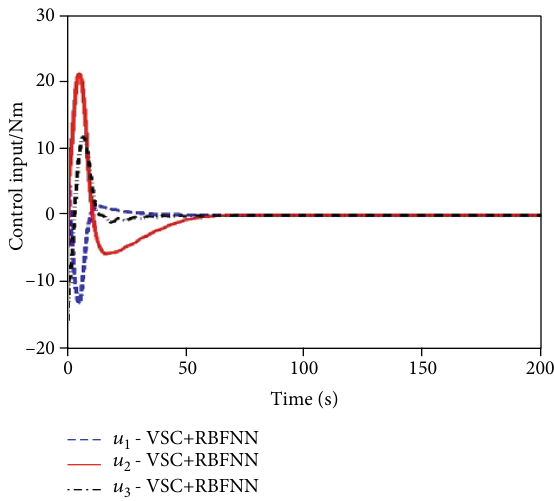
Figure 8: Time histories of control input in Case 1.